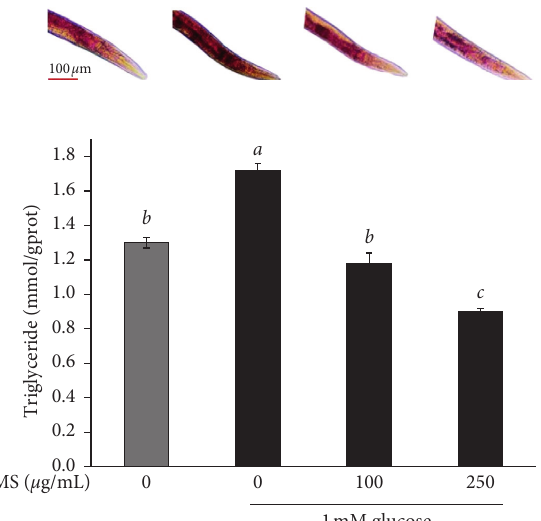
Figure 4: Effect of BMS on lipid accumulation (overall fat and TG content) in glucose-treated C. elegans . Values are expressed as means ± SE. Statistical analysis was performed using ANOVA. Different superscripts were considered significantly different. BMS: bitter melon